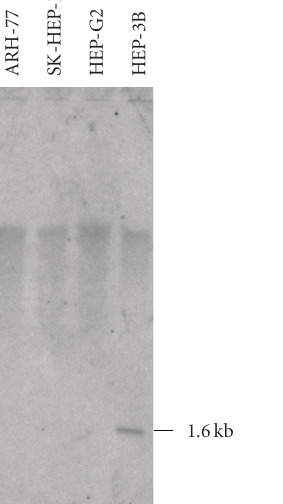
Figure 7: Southern blot analysis for the detection of HBV sequences in human cell lines. The cell lines HEP-3B, HEP-G2, and SK-HEP- 1 are cell lines established from human hepatocellular carcinomas. The ARH-77 is a human hematopoietic cell line and serves as a negative control. Genomic DNA was digested with Bam HI, separated on an agarose gel, blotted and hybridized with a 32 P labeled PCR fragment covering the Hepatitis B surface antigen coding region. The hepatocellular carcinoma cell lines SK-HEP-1 and HEP-G2 display no HBV sequences, whereas HEP-3B shows a hybridization signal at about 1.6kb originating from HBV sequences integrated into the cellular